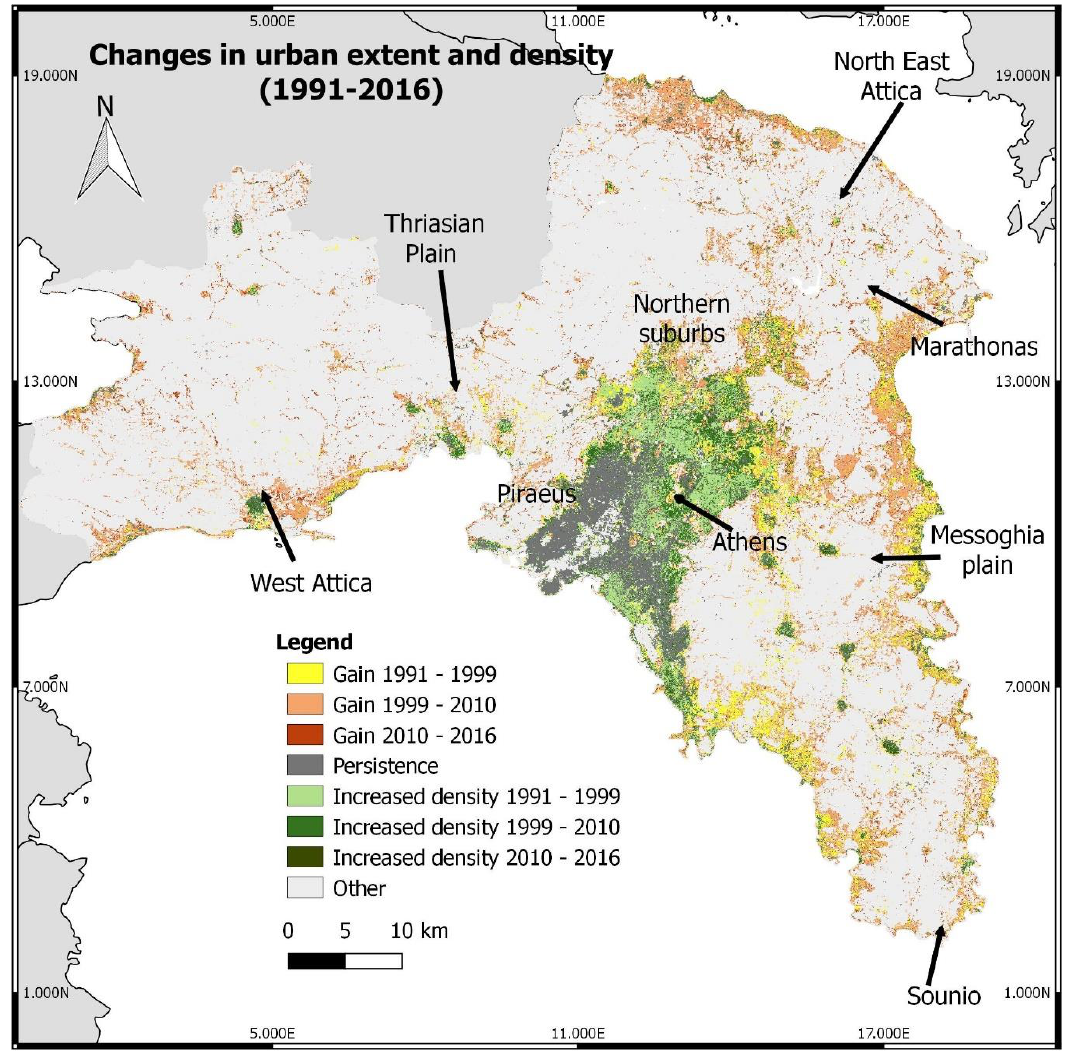
Figure 3. Urban trajectories observed between 1991 and 2016 (includes all urban fabric categories).